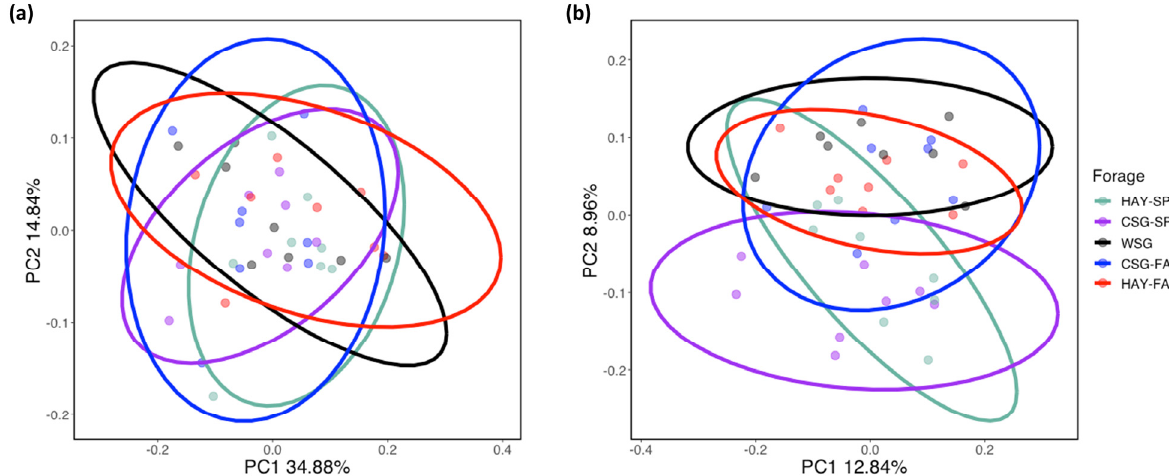
Figure 2. Fecal microbiota β -diversity across forages within an integrated rotational grazing system including: HAY-SP: initial standardized cool-season grass hay diet in the spring; CSG-SP: cool-season grass pasture in the spring; WSG: warm-season grass, either crabgrass or bermudagrass, in the summer slump period; CSG-FA: cool-season pasture in the fall; HAY-FA: final standardized cool- season grass hay diet in the fall. Weighted UniFrac ( a ) and Unweighted UniFrac ( b ) differed by forage based on analysis by Permutational ANOVA (PERMANOVA) ( p ≤ 0.05). Table 3. Bacterial co-abundance groups (BCG) 1 identified as markers 2 of standardized hay